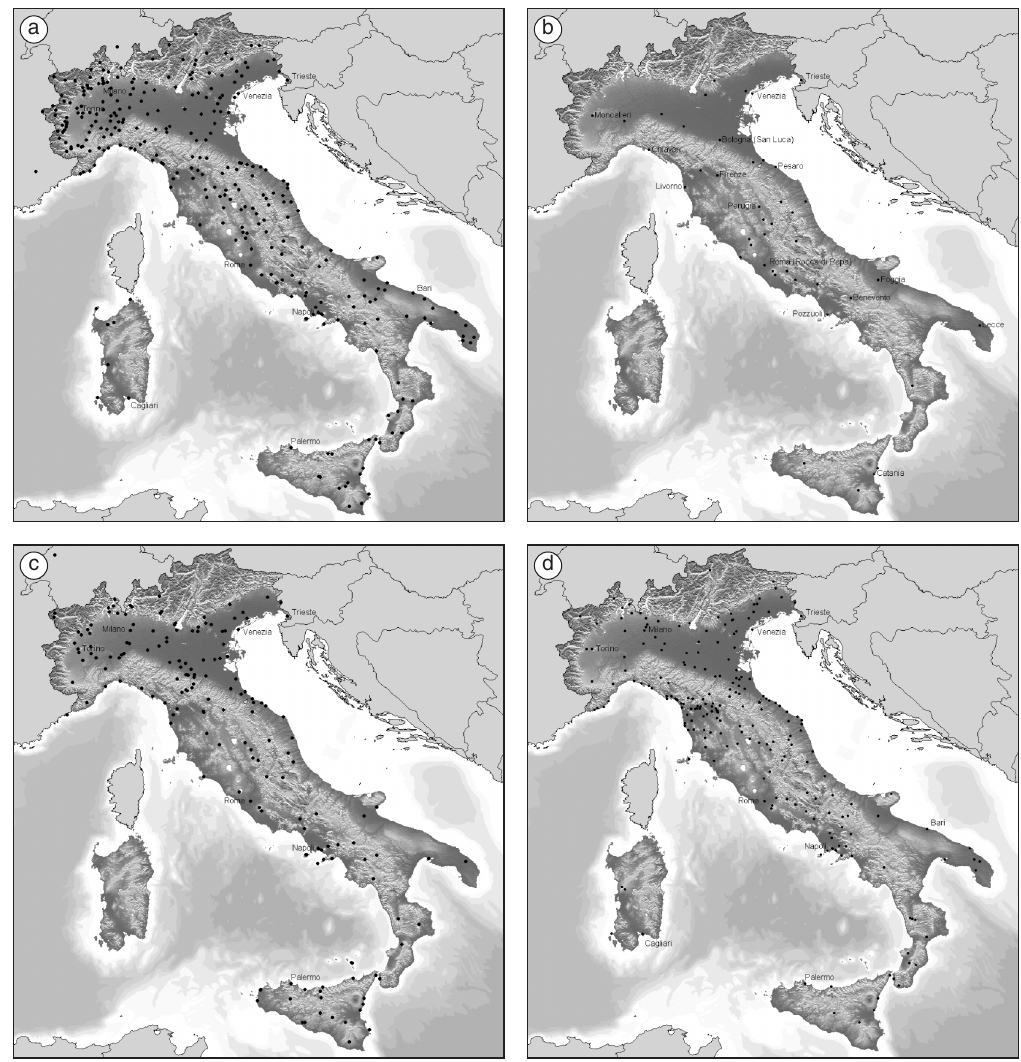
Fig. 1a-d. Maps of the geographic distribution of the correspondents of a) F. Denza; b) M.S. De Rossi; c) P. Tacchini and d) G. Alfani,